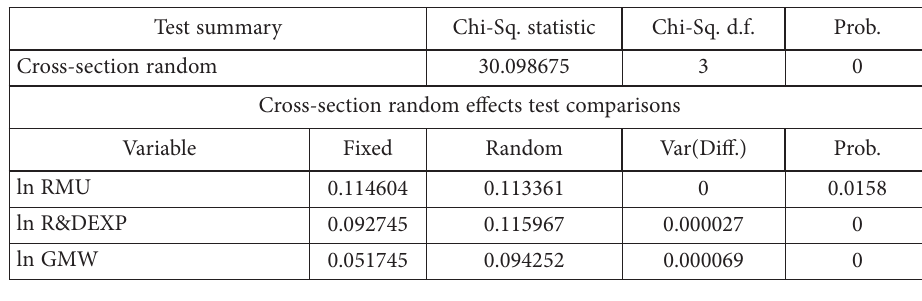
Table 8. Summary of the Hausman test